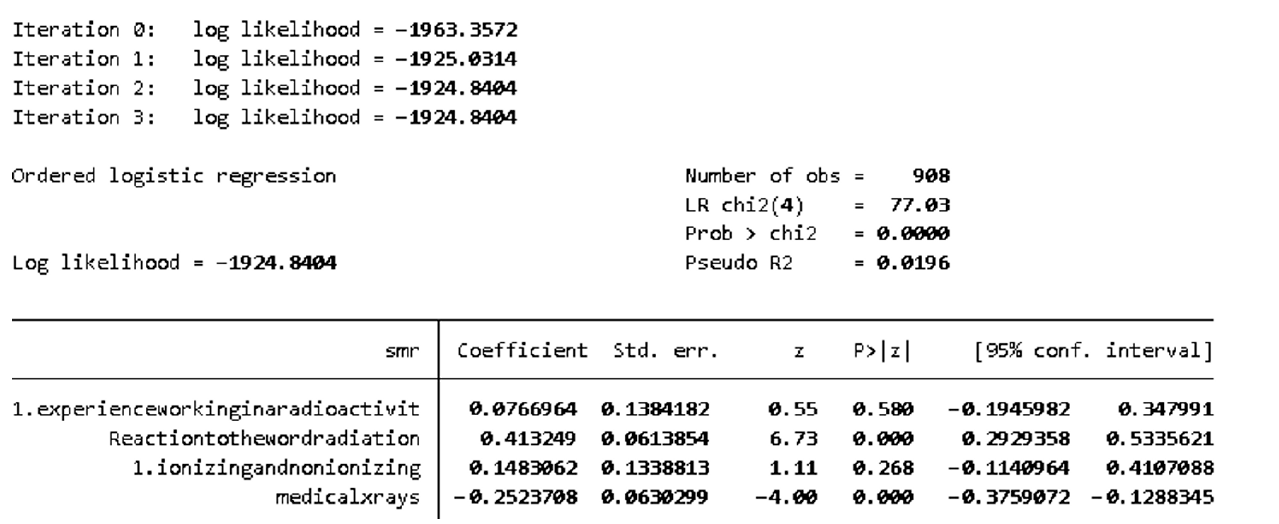
Figure A2. Model 2: Predicting survey respondents’ support for SMRs using ordered logistic regression in STATA.